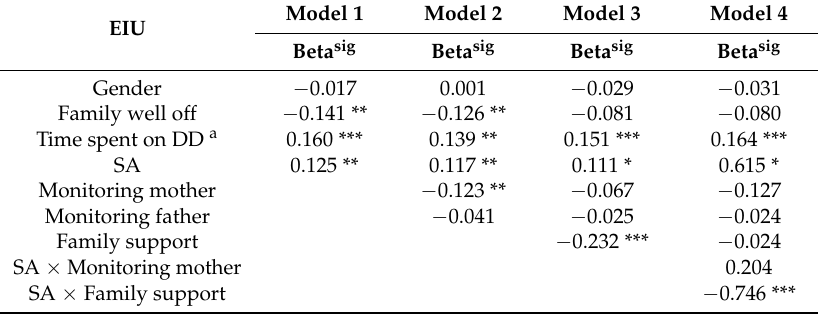
Table 2. Linear regression between excessive Internet use (EIU) and subculture affiliation (SA) subsequently adjusted for gender, family well off and computer use (Model 1), parental monitoring (Model 2), and family support (Model 3) and interactions of SA with monitoring by mother and family support (Model